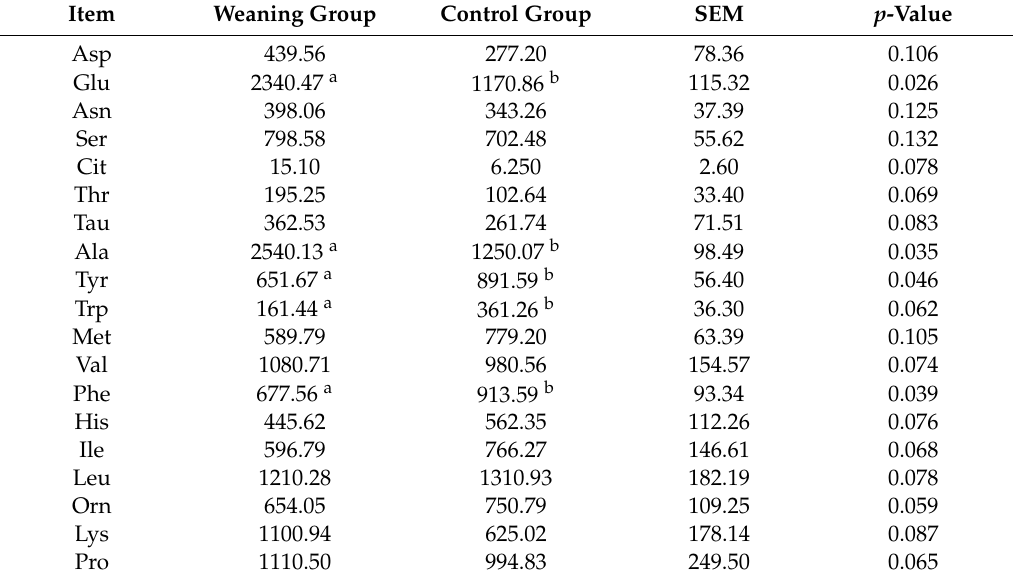
Table 1. E ff ects of weaning stress on free amino acid content in piglet liver (nmol /